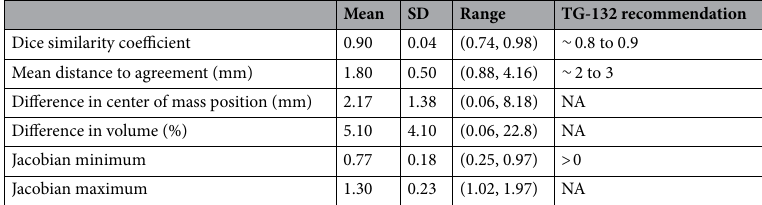
Table 1. Similarity metrics between auto and manual contours.